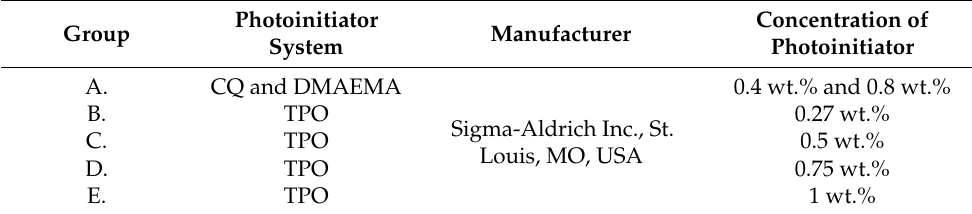
Table 1. The composition of the experimental composites tested in this study-55 wt.% of matrix involving Bis-GMA and TEGDMA (60/40 ratio) and 45 wt.% of silanized silica filler. Concentration of Photoinitiator Manufacturer Group Photoinitiator System 0.4 wt.% and 0.8 wt.% A. CQ and DMAEMA B. TPO 0.27 wt.% Sigma-Aldrich Inc., St. C. TPO 0.5 wt.% Louis, MO, USA D. TPO 0.75 wt.% E. TPO 1